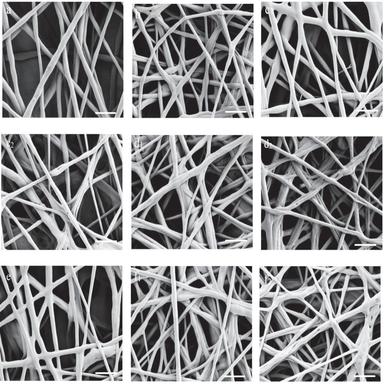
FESEM images of cross-linked PVA/PCM fibers with 8.0 wt% of GA before (a) and after different heat treatments (b) 60 ℃ for 4 h; (c1, c2) 80 ℃ for 3 h and 4 h; (d1, d2) 100℃ for 1 h and 2 h; (e) 120℃ for 30 min; (f1, f2) 80 ℃ for 10 cycles and 15 cycles. Here, one cycle means heating for 5 min and then cooling for another 5 min. Scale bar = 2 μm.